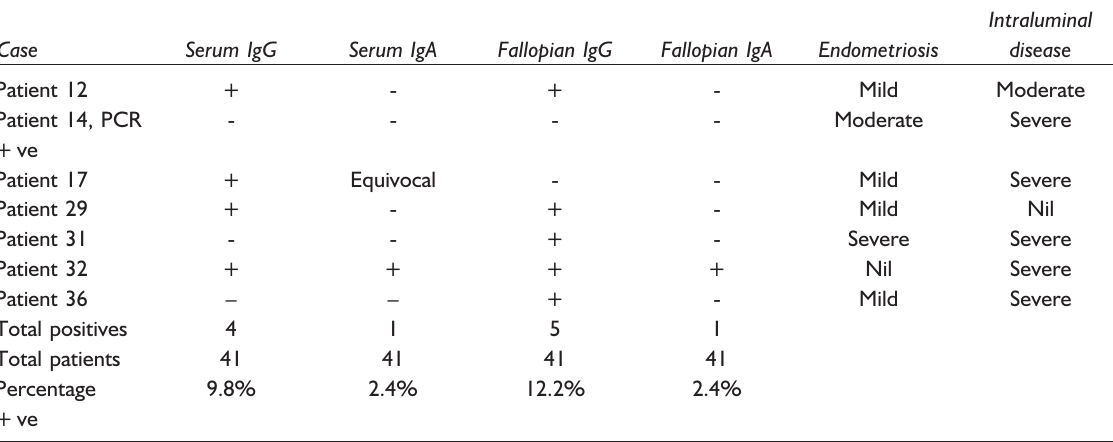
Table 1 Combined results of serum and fallopian tube C. trachomatis pathology